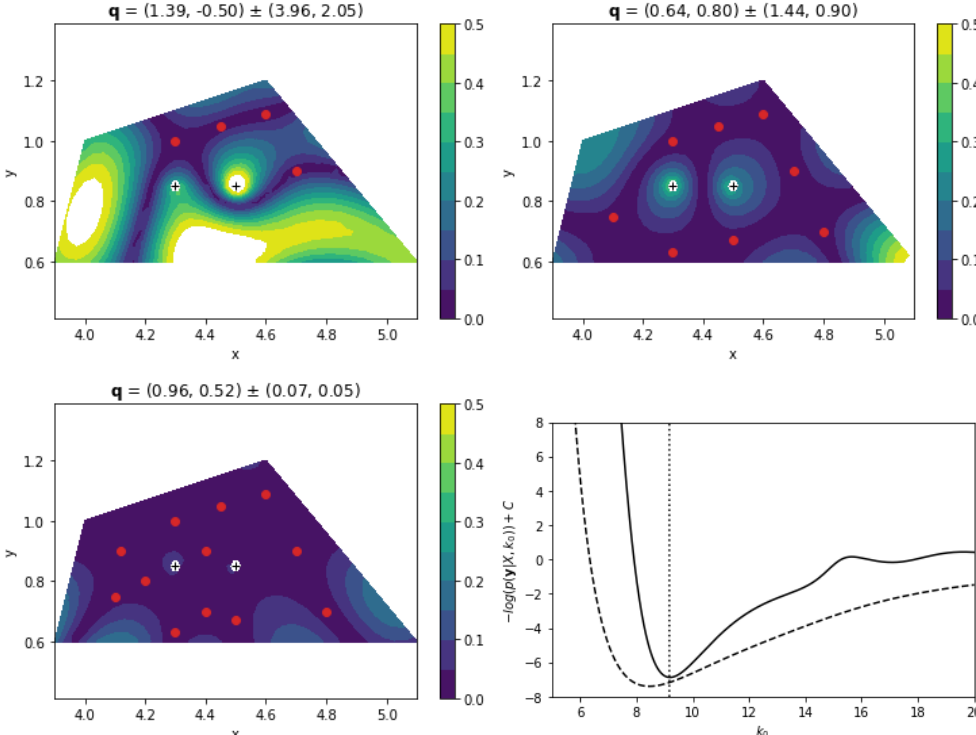
Figure 3. Reconstruction error for Helmholtz equation with different sensor count (top, bottom left) and reconstructed source strengths q with 95% confidence interval according to posterior (18) and (19). = 9.19 for Bessel kernel [11] (solid line), Negative log likelihood (bottom right) with optimum at k ML 0 whereas the actual value (dotted line) is k 0 = 9.16. The length scale of a squared exponential kernel (dashed line) is less